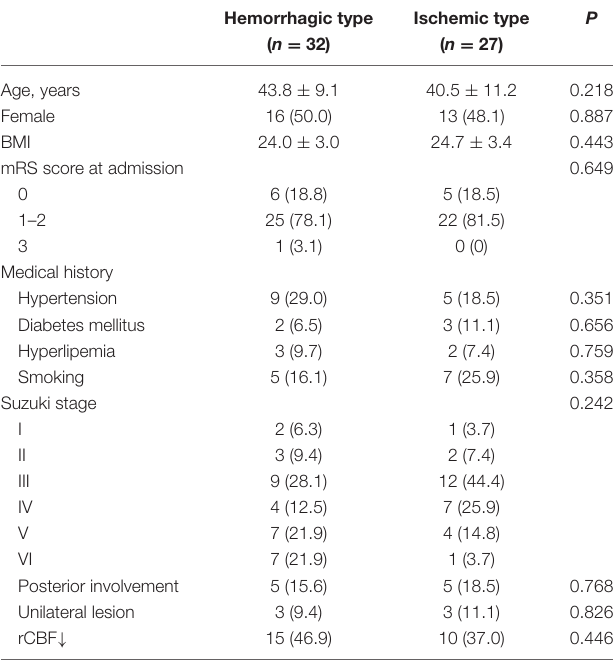
TABLE 2 | Characteristics of study patients in the adult subgroup. Hemorrhagic